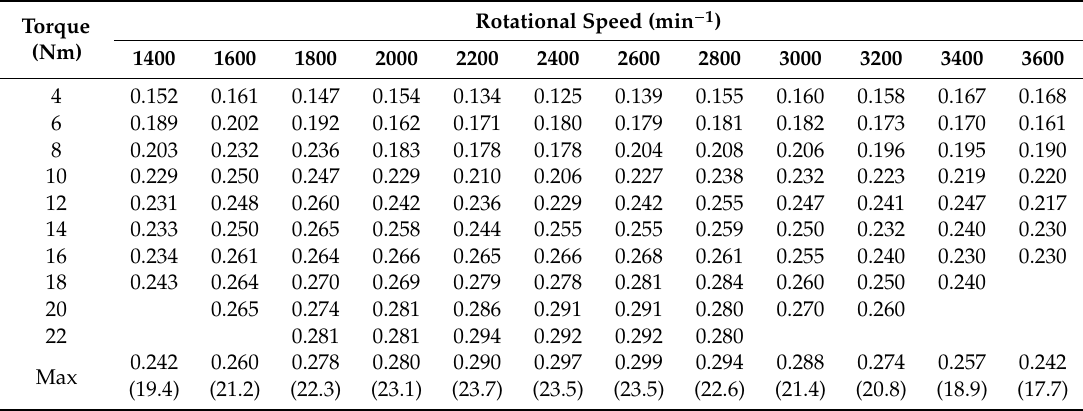
Table A3. Thermal e ffi ciency of range extender supplied with